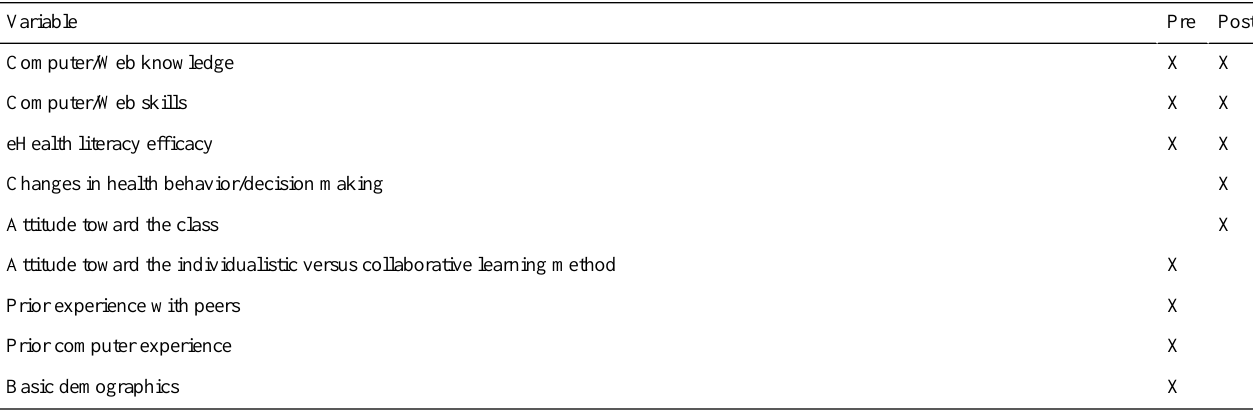
Table 2. Measures used in the present study and the time(s) of